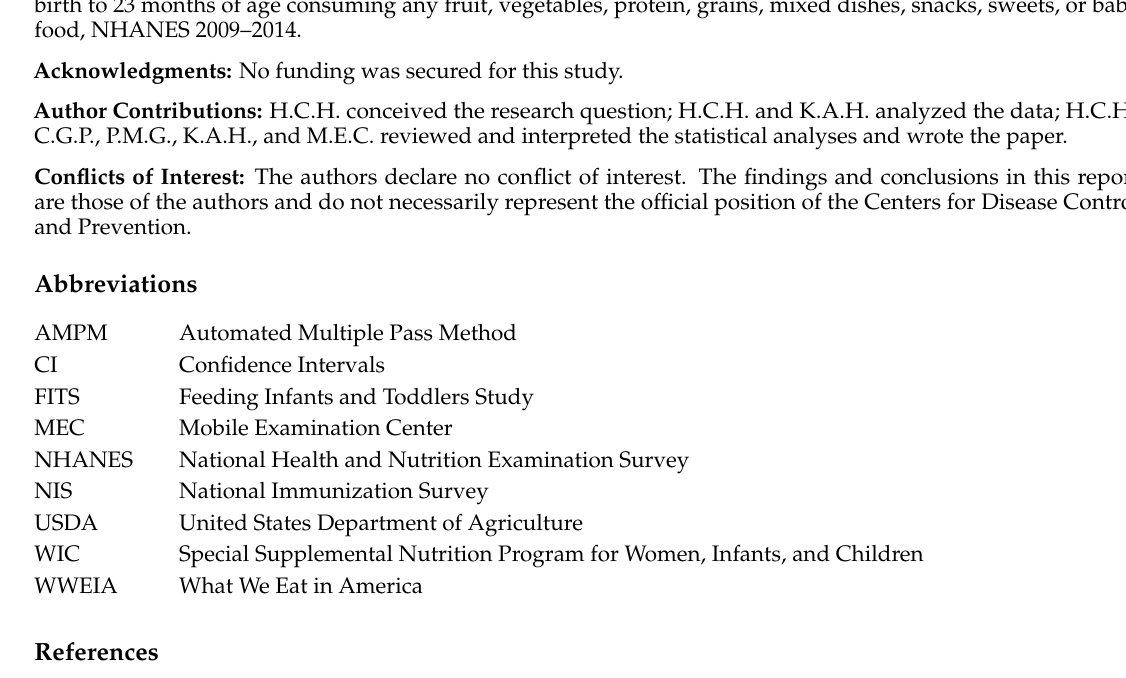
Table S1: Food and beverage categories and associated subcategories and the United States Department of Agriculture’s (USDA) What We Eat in America food categorization codes, Table S2: Percentage of U.S. children birth to 23 months of age consuming any fruit, vegetables, protein, grains, mixed dishes, snacks, sweets, or baby food, NHANES